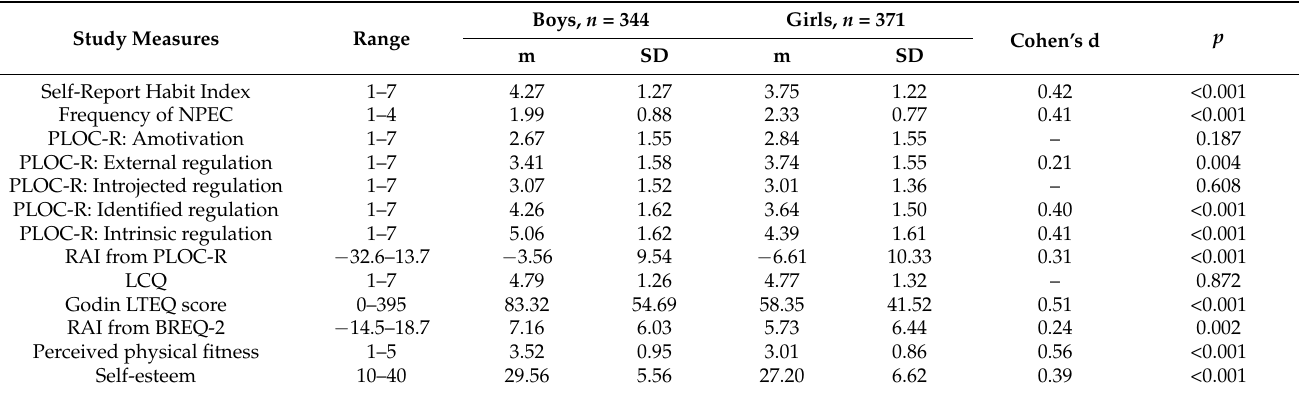
Table 1. Comparison of the study measures in gender groups with calculated effect sizes ( n = 715). Study